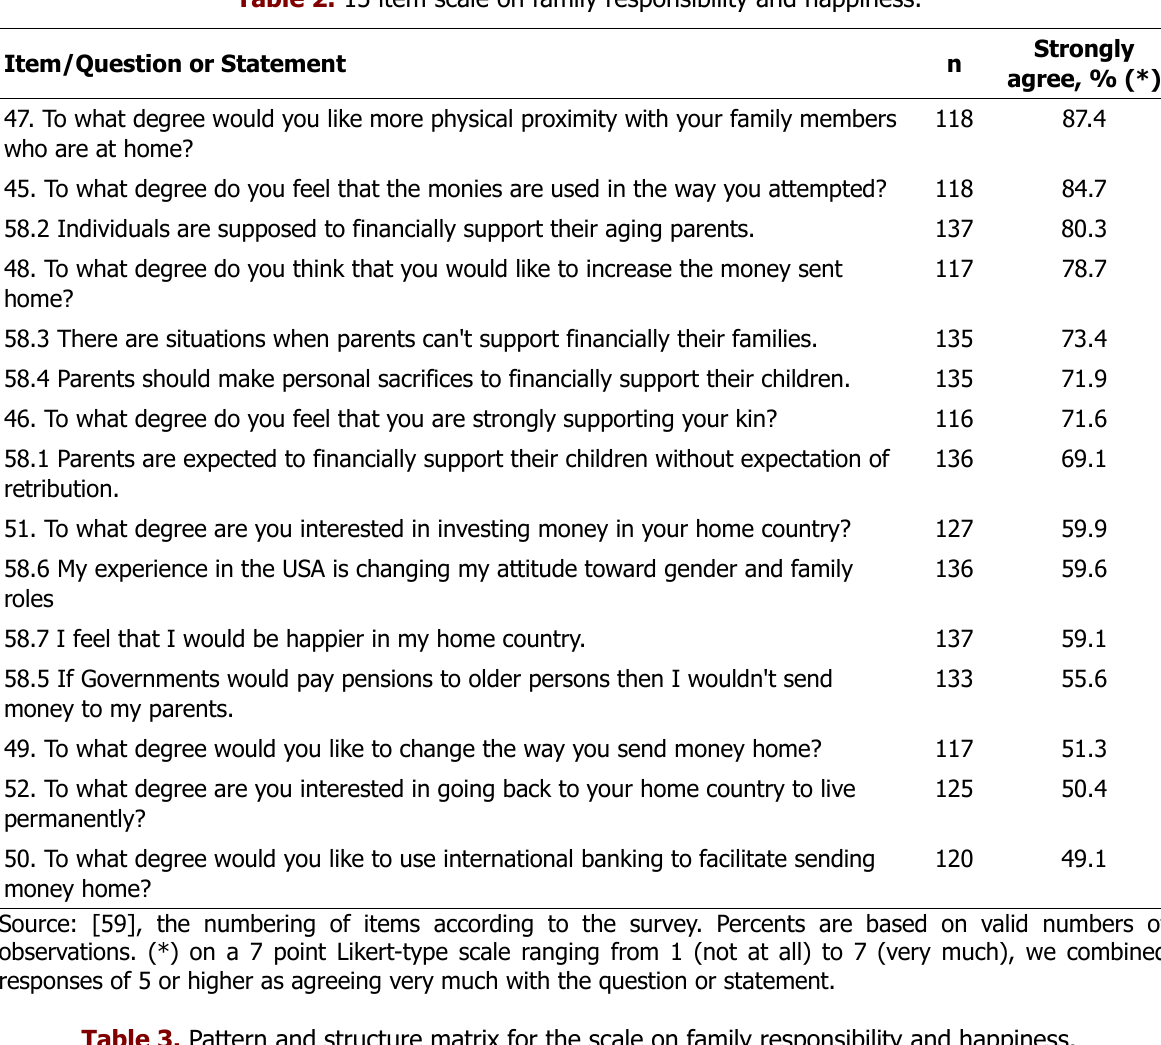
Table 3. Pattern and structure matrix for the scale on family responsibility and